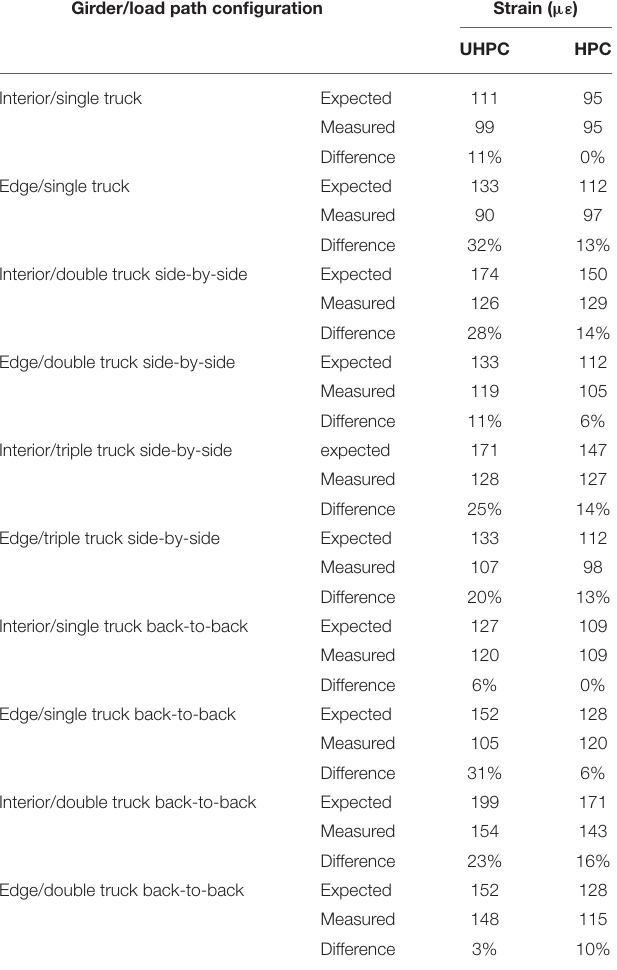
TABLE 9 | Stage 2 load test: expected vs. measured strain. Girder/load path